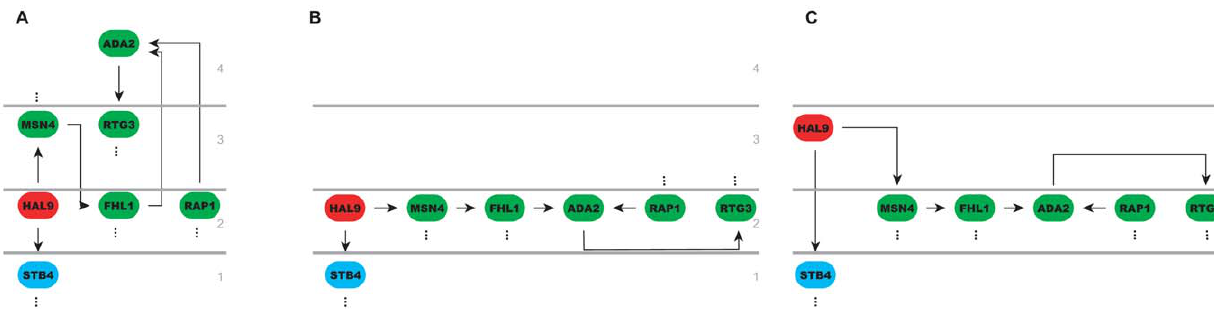
Figure 7. Comparison BFS-method vs. HiNO using the TRN of S. cerevisiae. A snapshot of the results (the comparison of the BFS-approach and HiNO) using the TRN of S. cerevisiae is shown. Node colors indicate the level assignment in HiNO: blue - level 1; green - level 2; red - level 3; yellow - level 4. Dashed edges represent additional regulatory interdependencies (further up- and/or down-stream factors) that are not shown. The results of the BFS method are shown in ( A ). The node coloring indicates conflicts in level assignment. In ( B ) the result of the ‘‘downgrade’’ step of HiNO is shown. In ( C ) the result of the ‘‘upgrade’’ step is shown. This is also the final hierarchical assignment of the elements by HiNO.